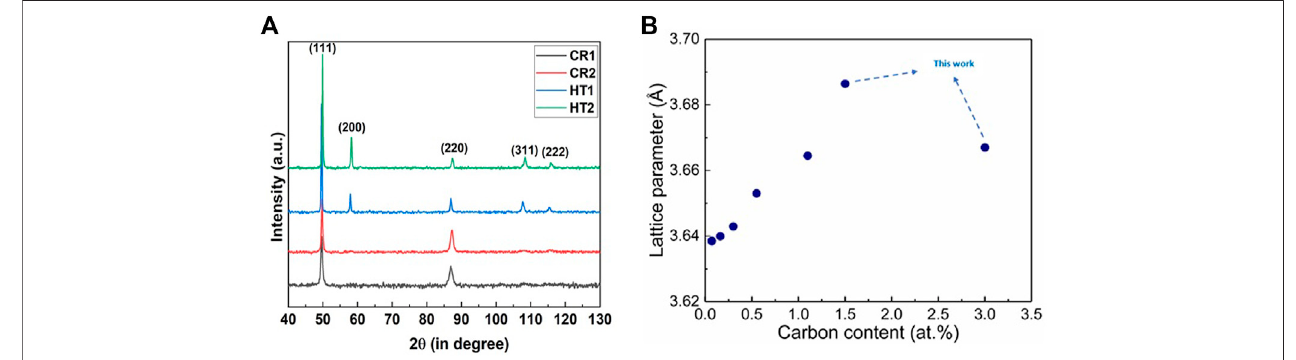
FIGURE 1 | (A) X-ray diffraction patterns of CR1, CR2, HT1, and HT2. (B) Variation of lattice parameters of Fe 40.4 Ni 11.3 Mn 34.8 Al 7.5 Cr 6 with carbon concentration.